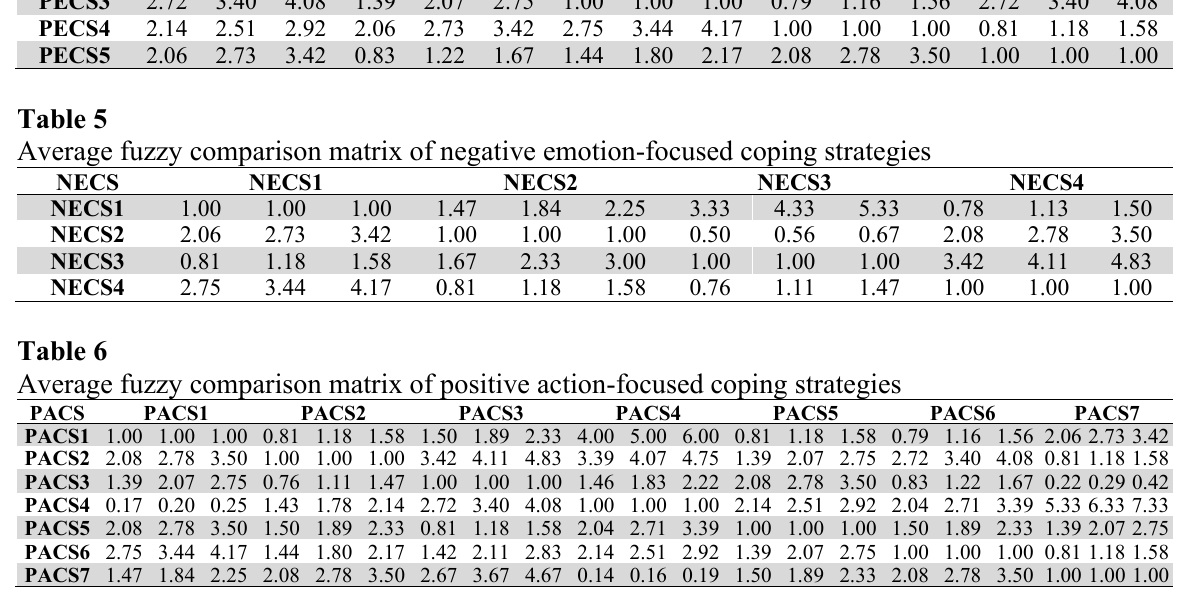
Average fuzzy comparison matrix of negative action-focused coping strategies NACS NACS1 NACS2 NACS3 NACS4 NACS1 1.00 1.00 1.00